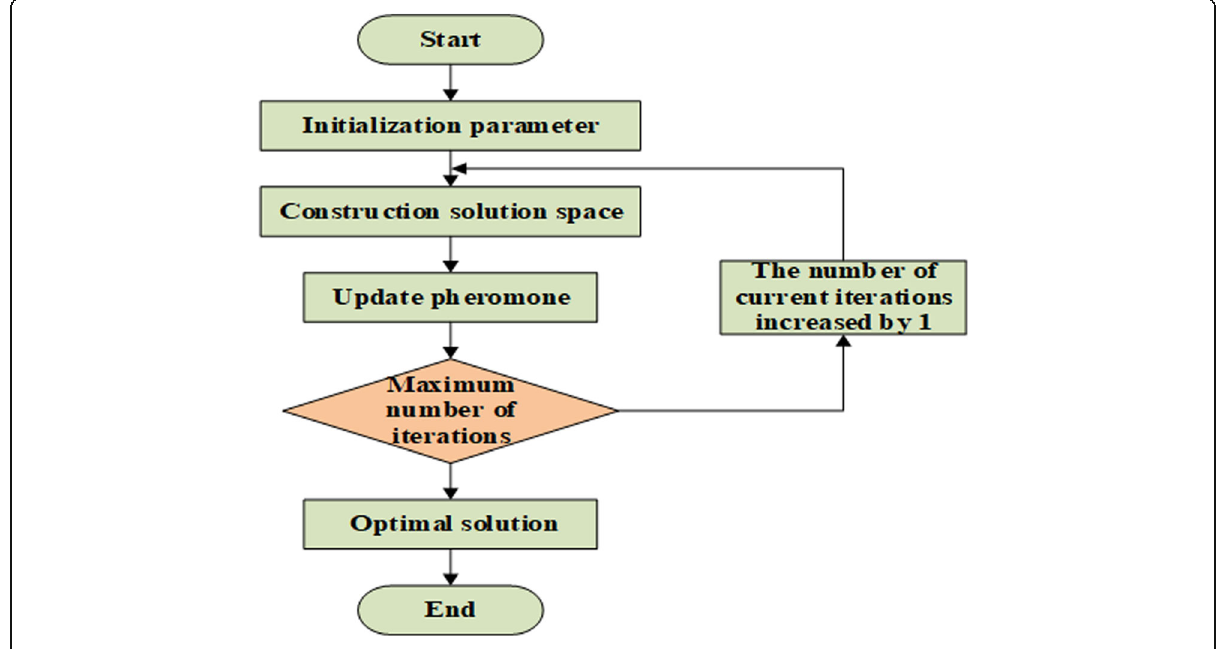
Fig. 3 The flow chart of ant colony algorithm